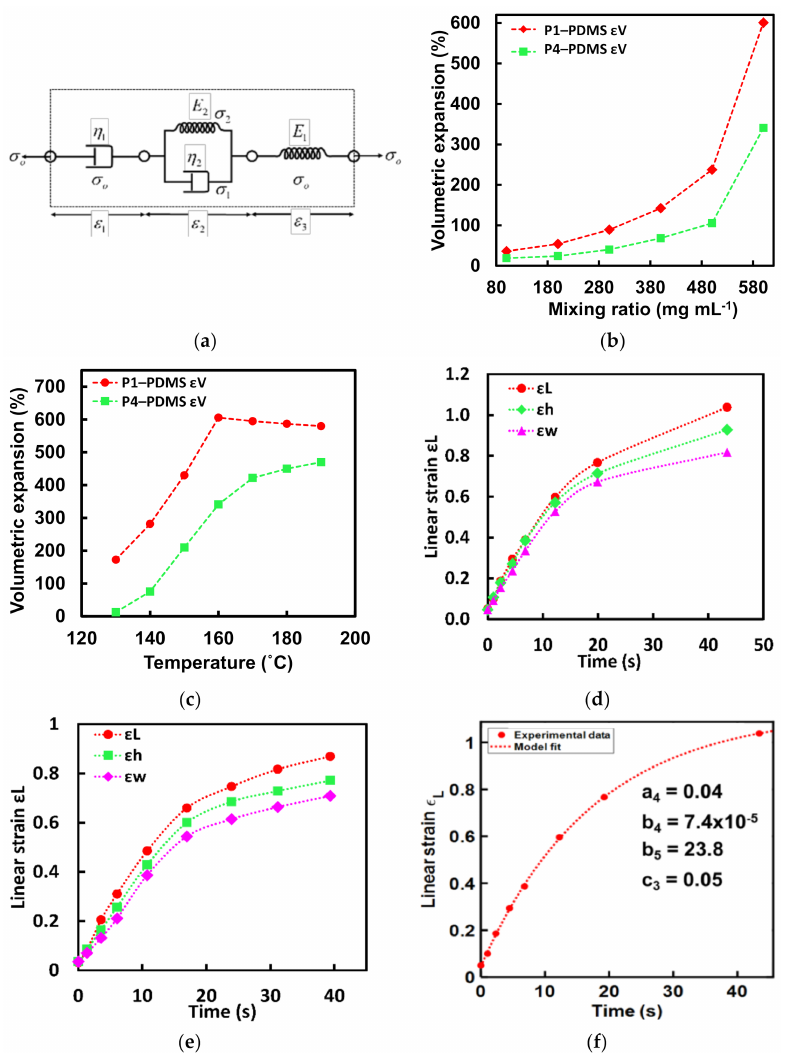
Figure 3. ( a ) A 4-element lumped parameter model with a Kelvin–Voigt and a Maxwell element connected in series representing a TEP-PDMS composite material with the constitutive stresses and strain. ( b ) Volumetric expansion of TEP-PDMS composite prepared with P1 and P4 TEP